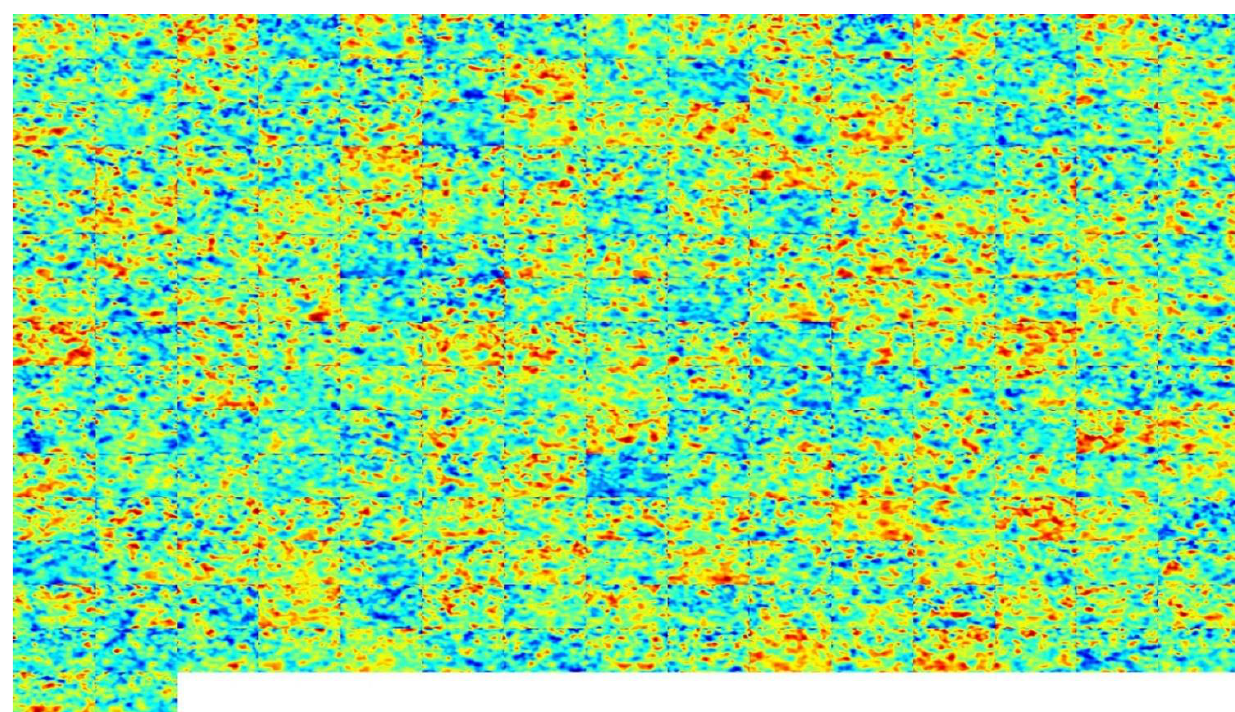
Figure 7. Total 227 number of separated 3D spectral features after Fast-ICA dimensionality reduction for lithological feature selection. The extracted features are sliced at an elevation of 1000 m.